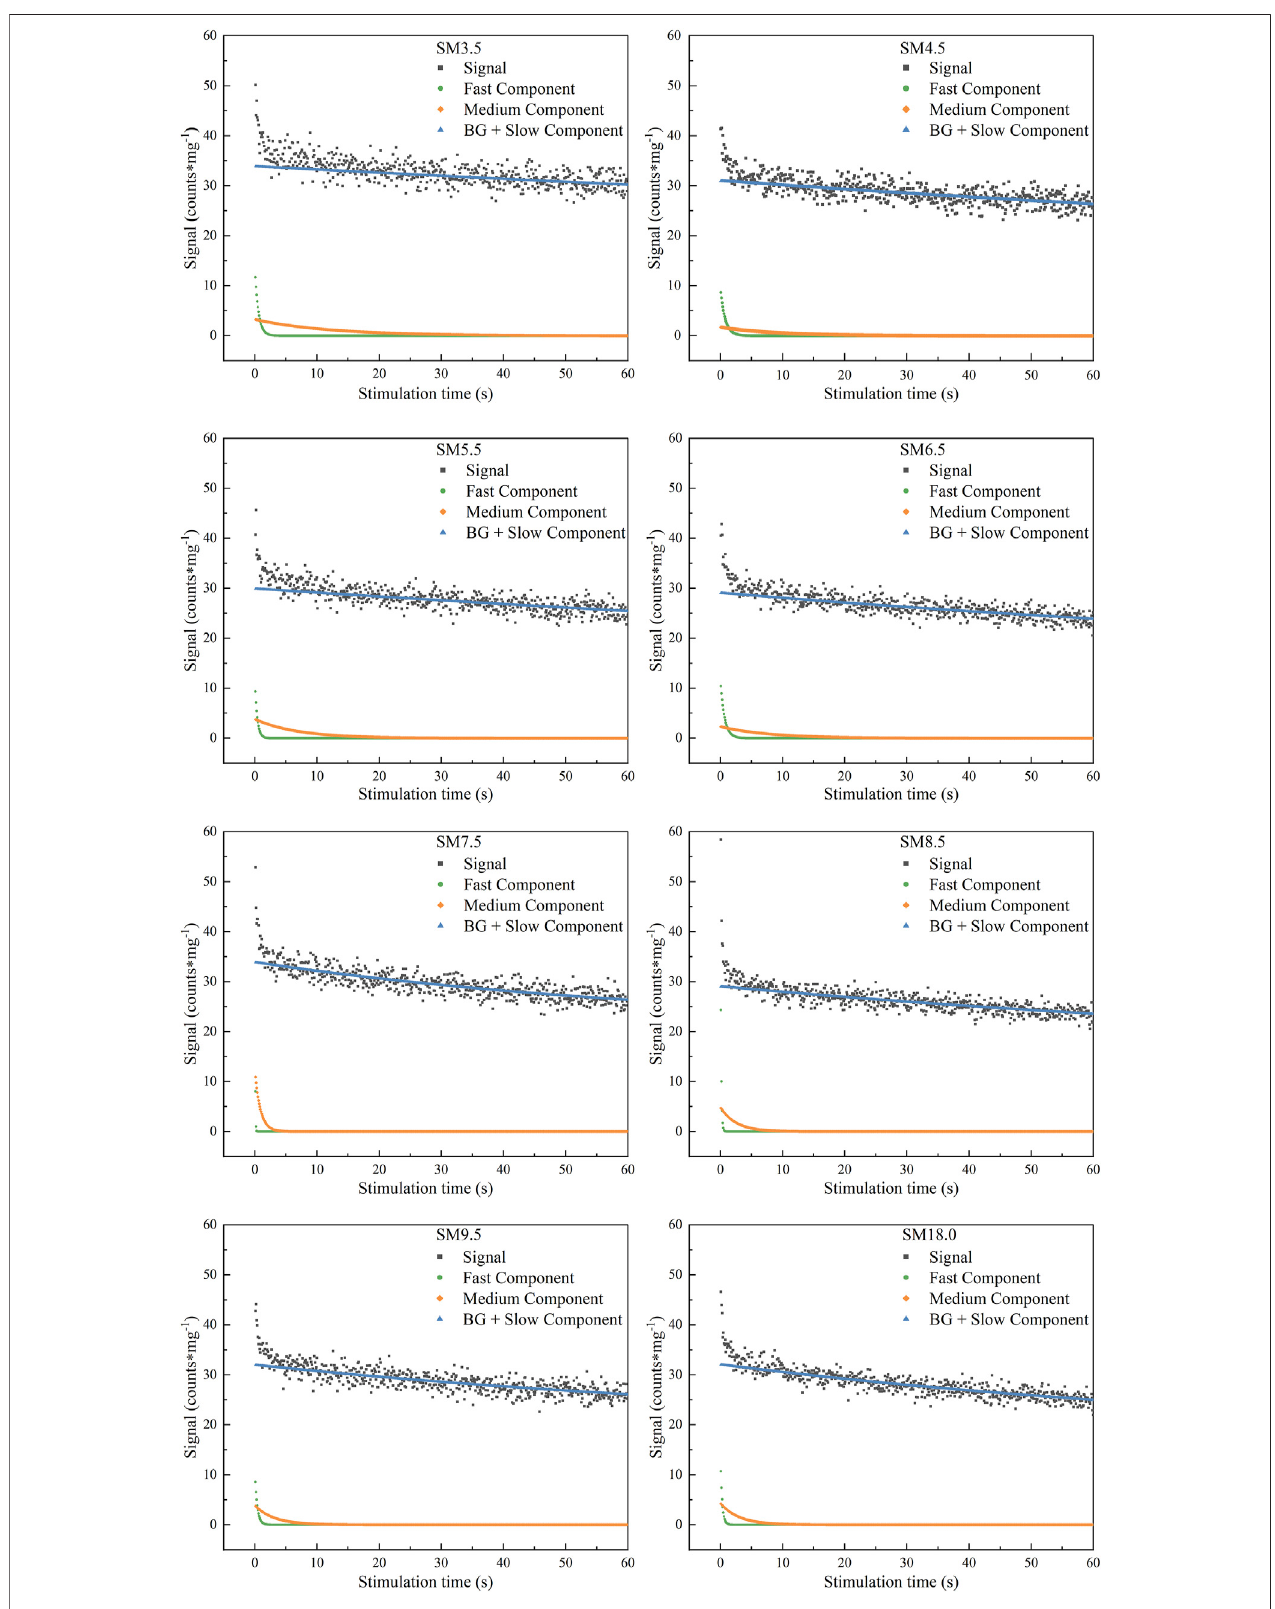
FIGURE 4 | The decay curves of 8 samples and the fast, medium and slow components obtained after curve deconvolution. Since the fast and medium components decayed rapidly to zero and the slow component decayed at a constant rate, only the fi rst 60 s of data were intercepted and plotted.